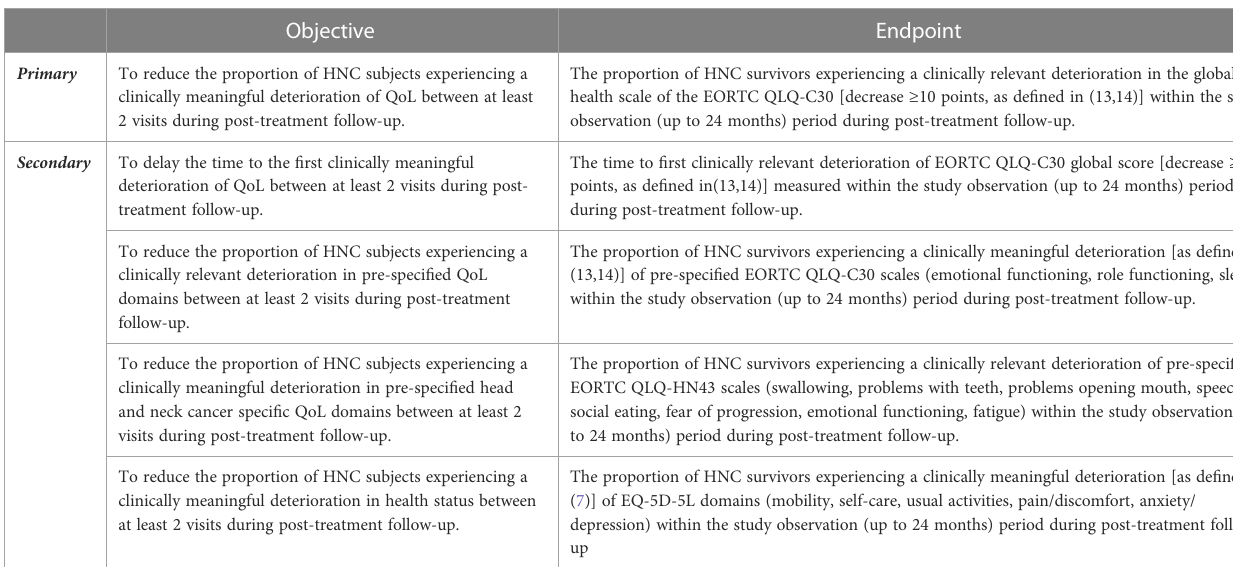
TABLE 1 Study objectives and